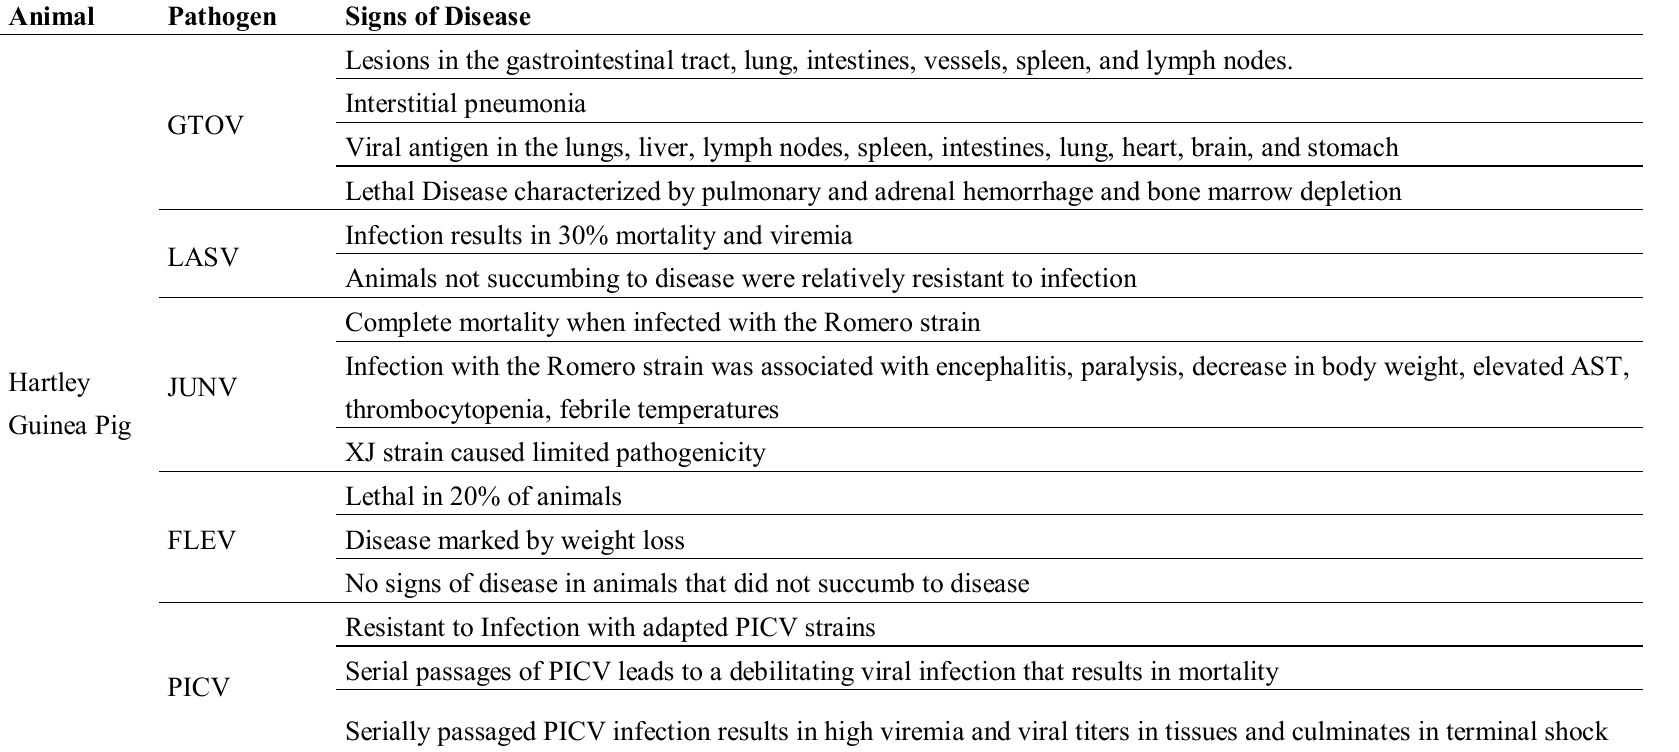
Table 1. Arenavirus — Guinea Pig